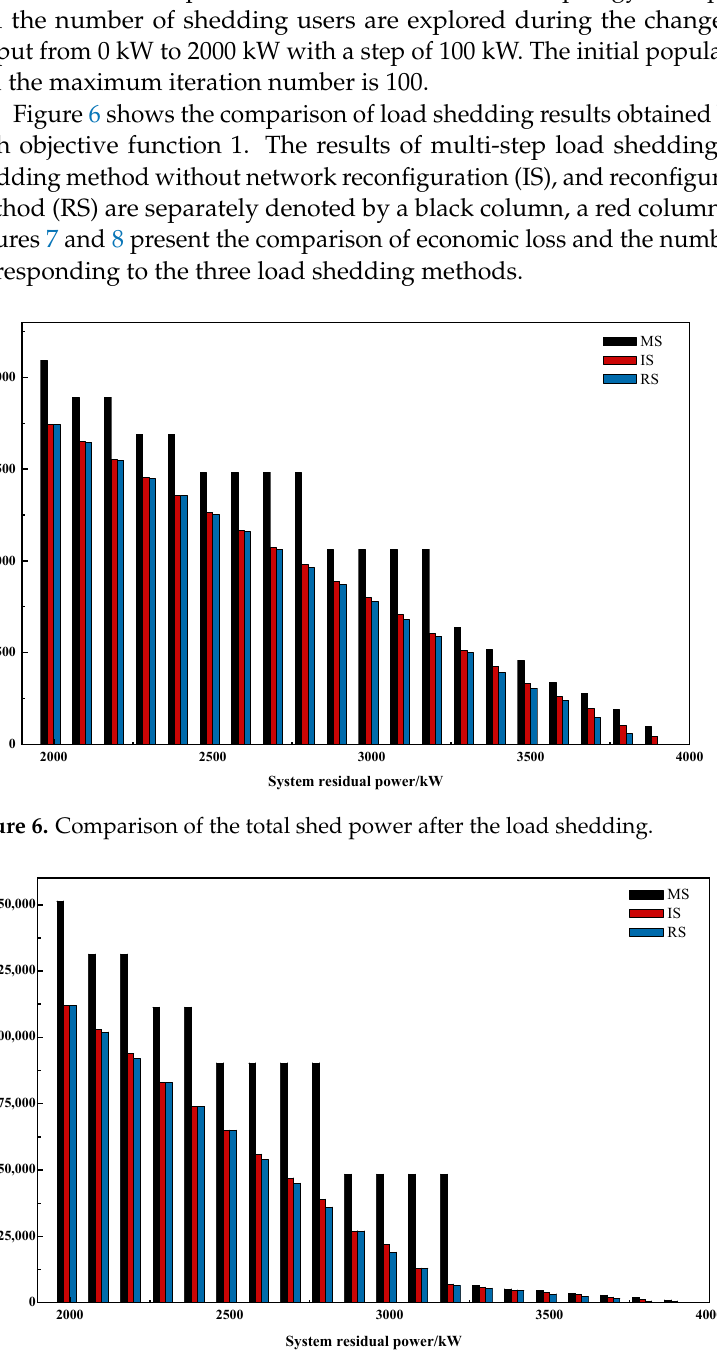
MS IS RS Figure 8. Comparison of the total shedding users after the load shedding.